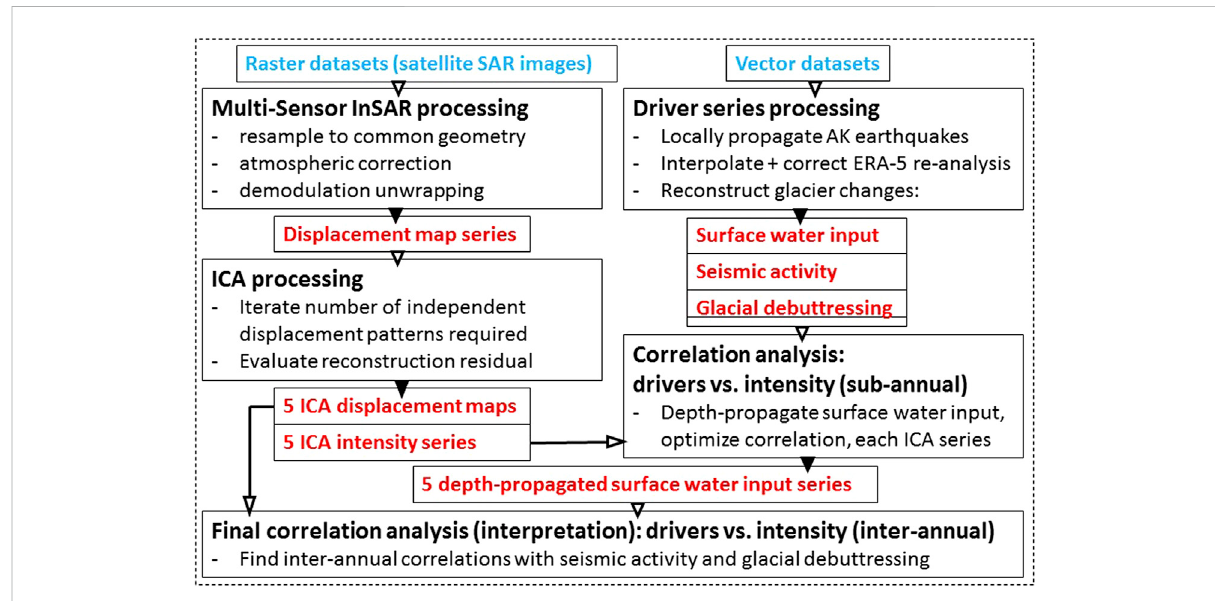
FIGURE 4 Methodology fl owchart. Solid and hollow arrowheads indicate outputs and inputs; blue and red print indicate primary input and intermediate products,